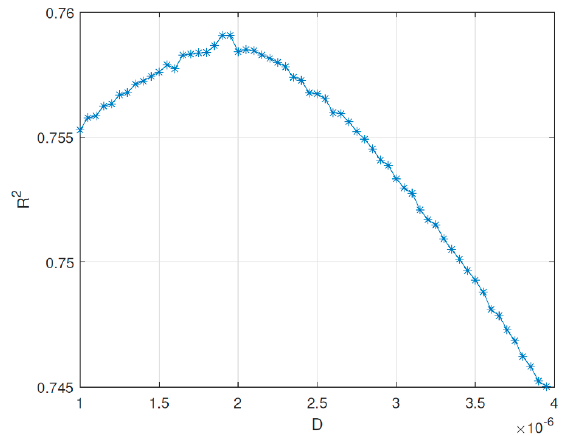
Figure 4. The greatest value of R 2 for the density-dependent mortality coefficient D.